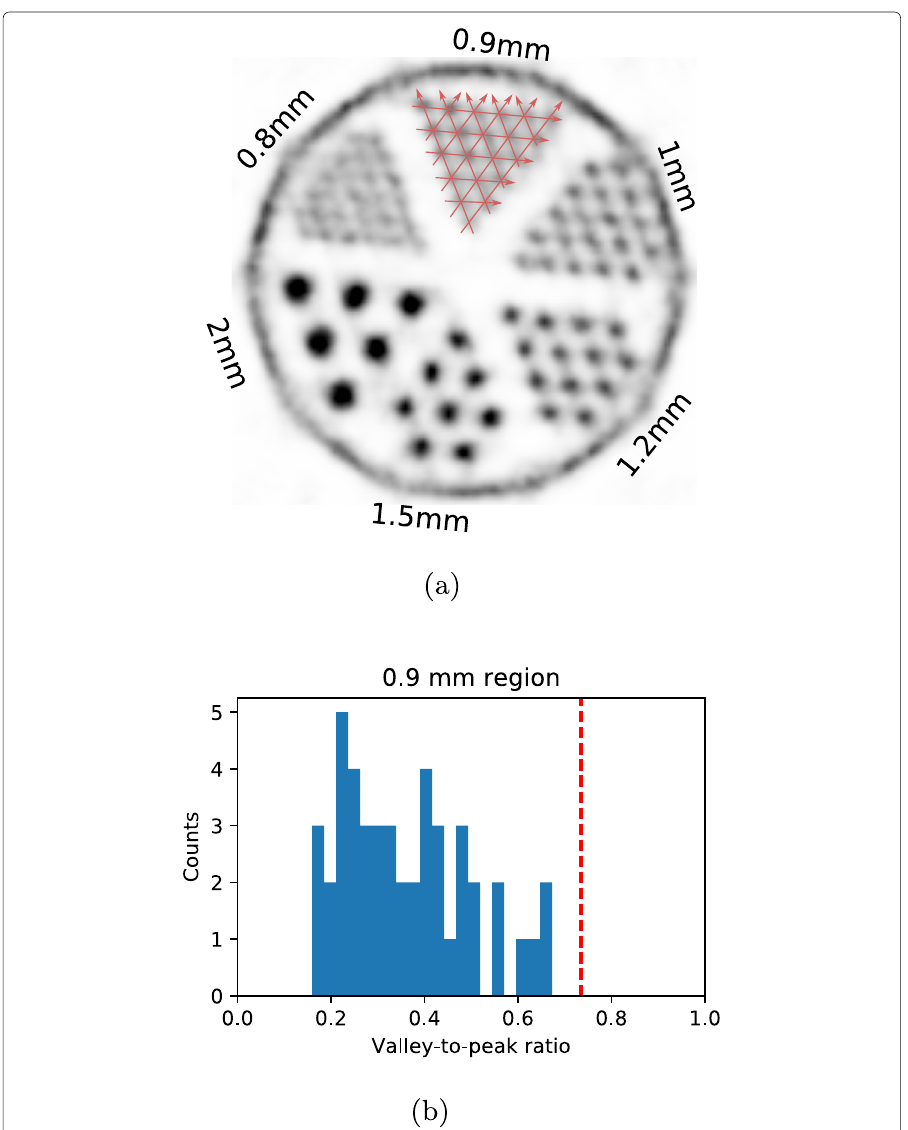
Fig. 4 Evaluation of spatial resolution using a Derenzo phantom. a Reconstruction of Derenzo phantom scan. The labels indicate the diameters and the distance between the rods. The red lines show an example of profile lines which would be used for determination of valley-to-peak ratios to evaluate the spatial resolution. b Distribution of valley-to-peak ratios for the region with a rod distance of 0.9mm. All ratios are below 0.735, which is marked with a red vertical